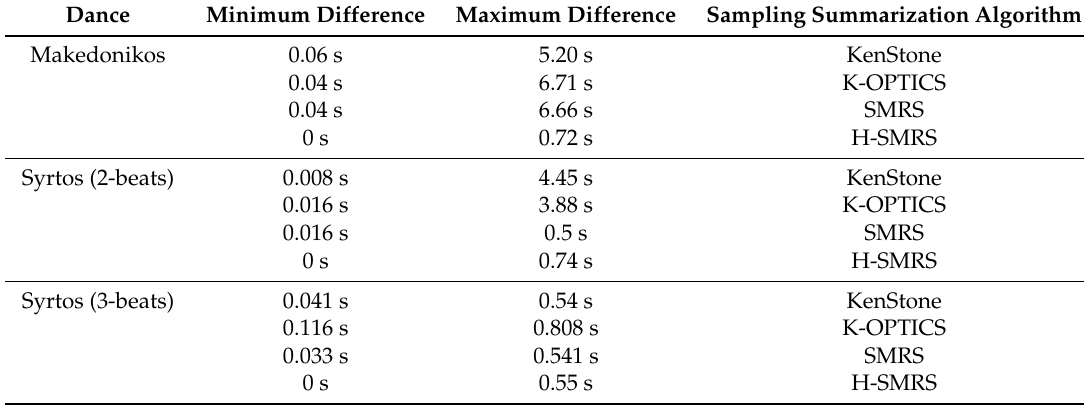
Table 5. The minimum (best) and maximum (worst) time deviation ( µ max ) among the key frames extracted using a summarization algorithm and the ground truth data. The comparison is carried out using four summarization algorithms, K-OPTICS, Kennard Stone, SMRS and H-SMRS and for the three dances.The values are in